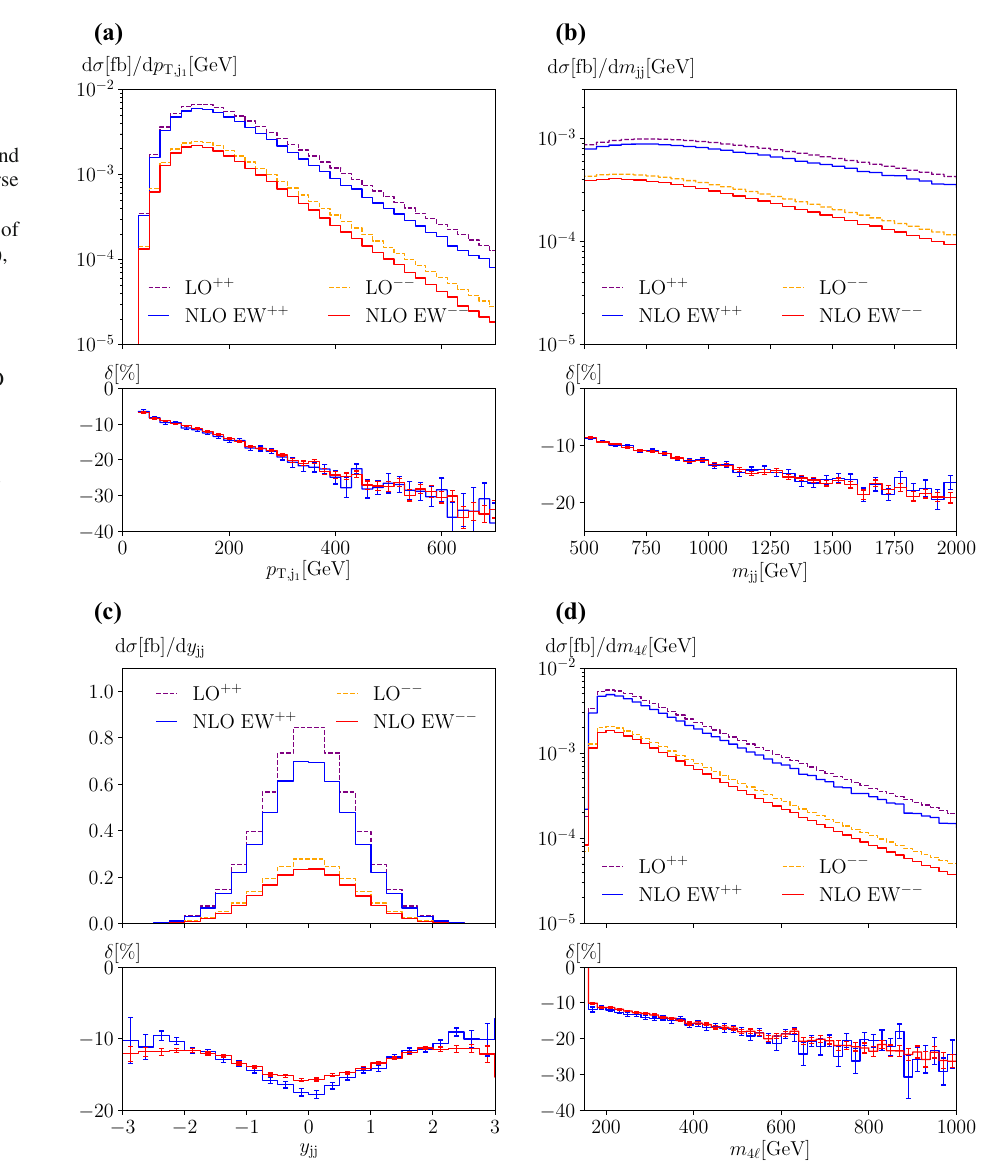
Fig. 2 Differential distributions at LO [order (cid:2) (cid:3) α 6 O ] and NLO EW [order (cid:2) (cid:3) α 7 O ] for a centre-of-mass √ s = 13TeV at the energy LHC for pp → μ + ν μ e + ν e jj and pp → μ − ¯ ν μ e − ¯ ν e jj: a transverse momentum of the hardest jet (top left), b invariant mass of the two leading jets (top right), c rapidity of the two leading jets (bottom left), and d invariant mass of the four leptons (bottom right). The upper panels show the two LO contributions as well the two NLO predictions. The lower panels show the relative NLO corrections with respect to the corresponding LO in per cent